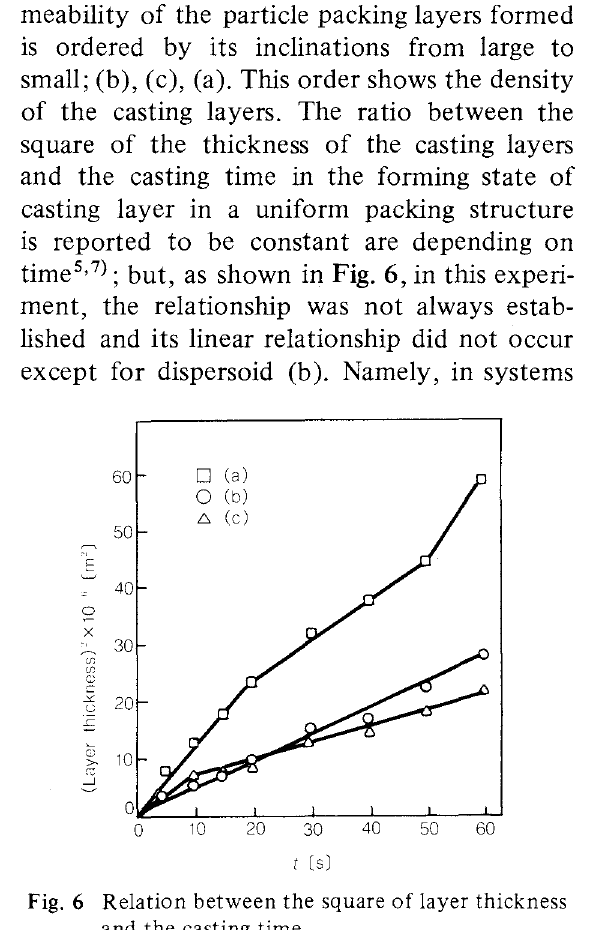
Fig. 6 Relation between the square of layer thickness and the casting time (a) and (c), initially with a porous casting layer